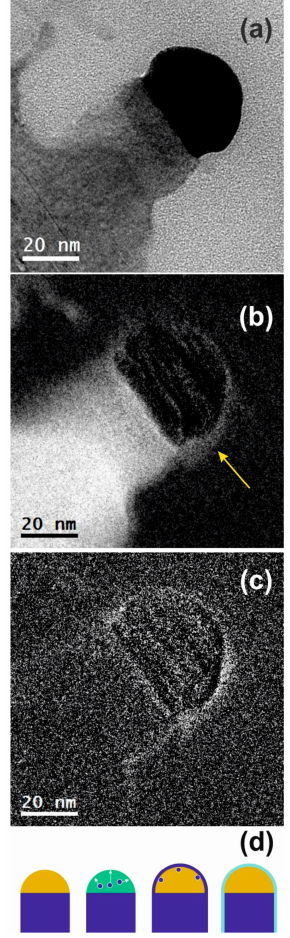
Figure 2. Transmission electron microscopy (TEM) micrograph acquired in bright field conditions of a Si-NW on < 100 > Si substrate ( a ). Silicon map ( b ) and oxygen map ( c ) acquired through energy filtered TEM (EFTEM) analysis on the same nanowire. A thin layer (indicated by the yellow arrow in b ) is observed around the metal dot. Schematics illustrating the mechanisms of SiO 2 layer formation around the Si-NWs tip ( d